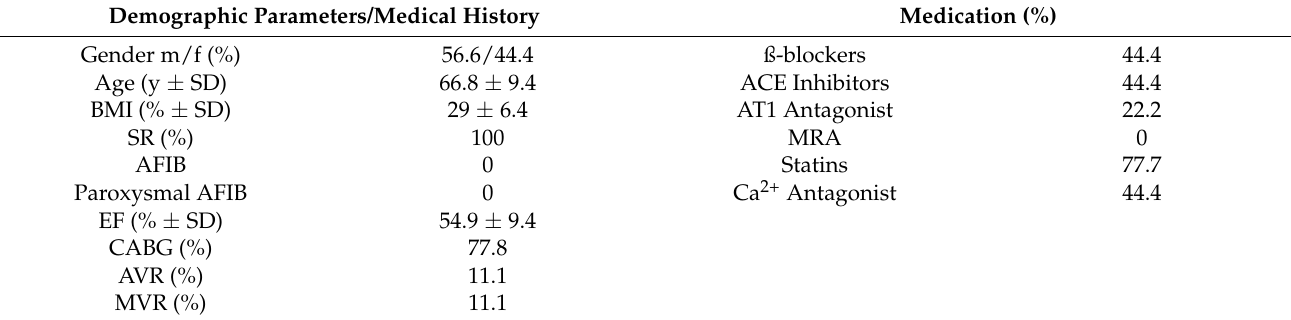
Table 1. Baseline characteristics of patients that underwent surgical interventions providing atrial muscle strip